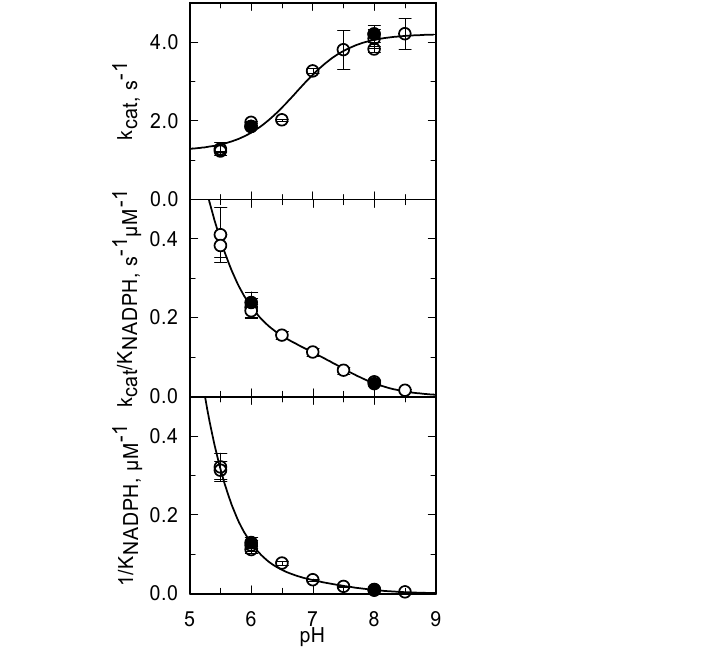
, K and k / K were cat NADPH cat NADPH